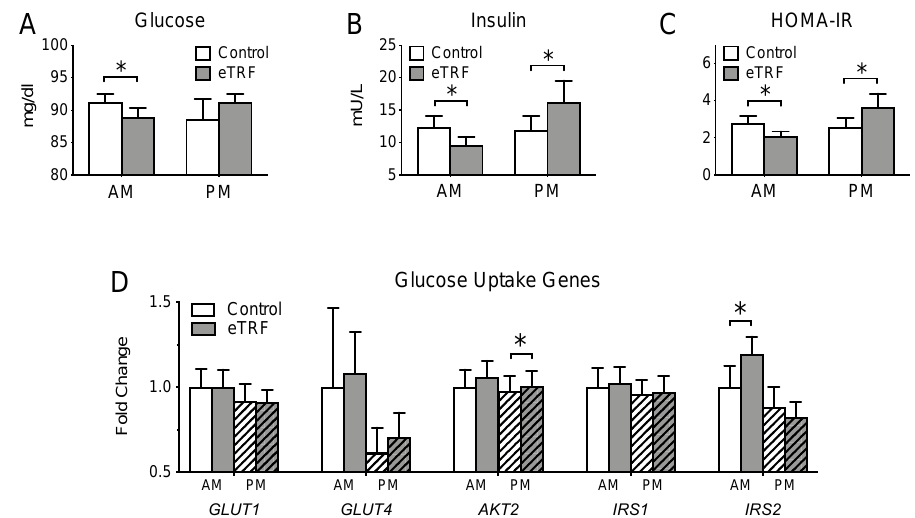
Figure 3. Glycemic Markers. Relative to the control schedule, early time-restricted feeding (eTRF) decreased ( A ) fasting glucose, ( B ) fasting insulin, and ( C ) Homeostatic Model Assessment of Insulin Resistance (HOMA-IR) in the morning (AM) and increased ( B ) fasting insulin and ( C ) HOMA-IR in the evening (PM). ( D ) eTRF also increased the expression of the IRS2 and AKT2 genes in the morning and evening, respectively. Data for GLUT1 and GLUT4 are shown excluding a participant whose expression levels were ~10× higher than the sample mean. * p < 0.05.